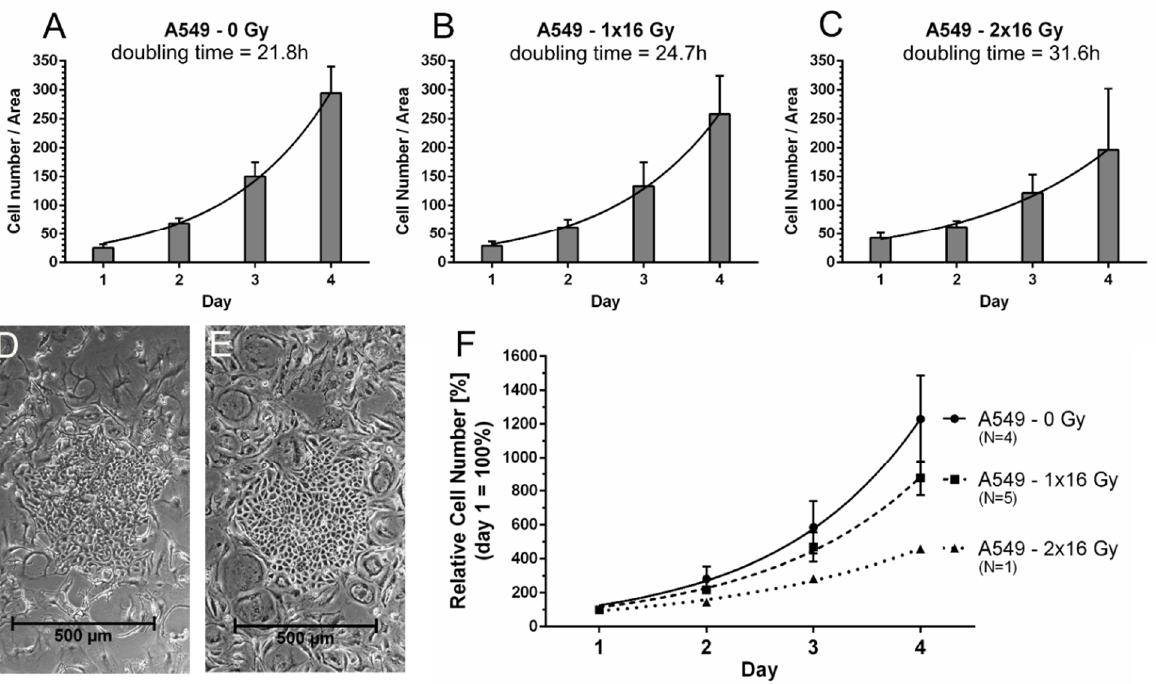
Figure 12. Proliferation and doubling times of A549 cells before irradiation and after regrowth of colonies of non-senescent cells several weeks after 1 × 16 Gy and 2 × 16 Gy gamma-irradiation. After counting the cell number per randomly chosen area on four consecutive days, an exponential growth equation was used to extrapolate the doubling time of the respective tumor cell population. The doubling time of untreated A549 cells was calculated to be 21.8 h on average (N = 4, R 2 = 0.91). After 1 × 16 Gy gamma-irradiation and the regrowth of proliferating tumor cells out of the initially senescent cell population, a doubling time of 24.7 h on average (N = 5, R 2 = 0.96) was seen, and after 2 × 16 Gy, the doubling time slowed down to 31.6 h on average (N = 1, R 2 = 0.99). Exemplary growth curves for each group are shown in A (0 Gy), B (1 × 16 Gy), and C (2 × 16 Gy). A representative proliferating tumor cell colony at day 15 after 1 × 16 Gy is shown in D . The partial image E shows the regrowth of proliferating tumor cells 27 days after 2 × 16 Gy. The second irradiation cycle was applied six days after the first one. From the single cell counts, general growth curves for untreated A549 cells, and those which survived 1 × 16 Gy, or 2 × 16 Gy were extrapolated ( F ). It can be seen that proliferative capacity is regained after gamma-irradiation, but cell doubling slows down.